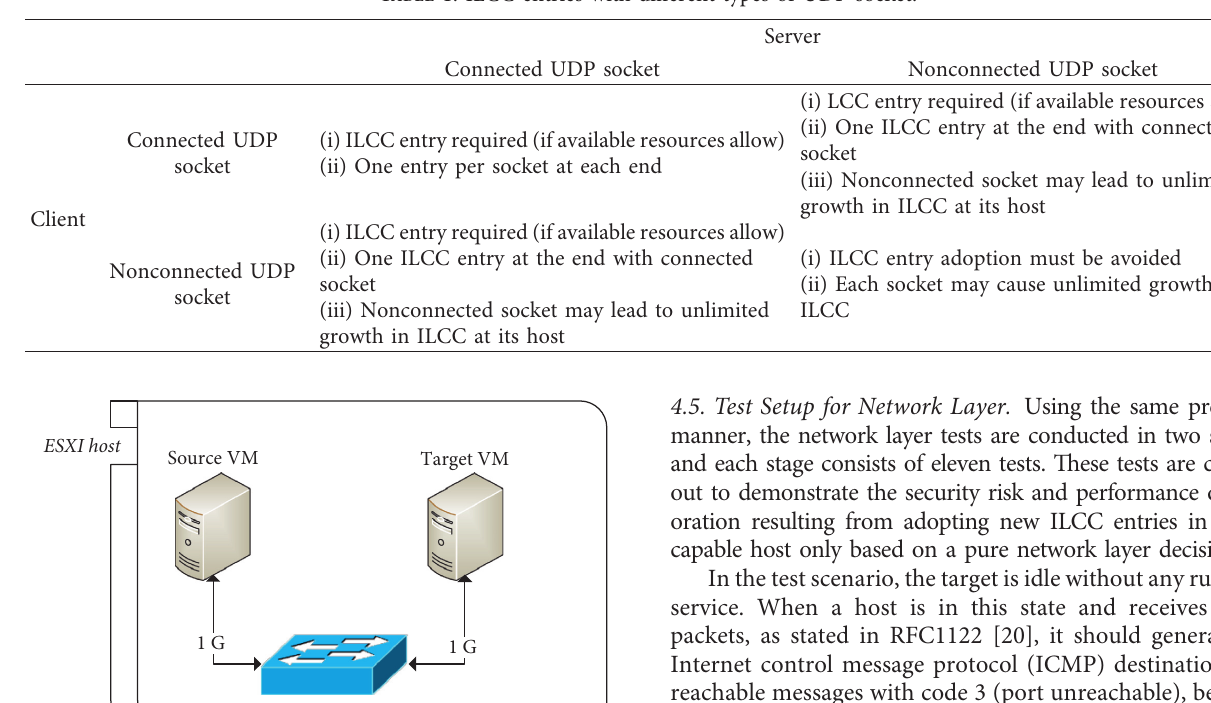
Table 1: ILCC entries with different types of UDP socket.